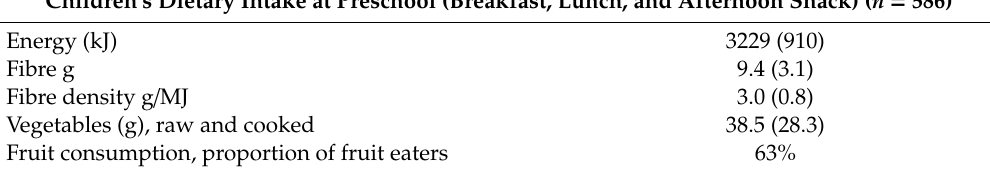
Table 4. Children’s dietary intake at